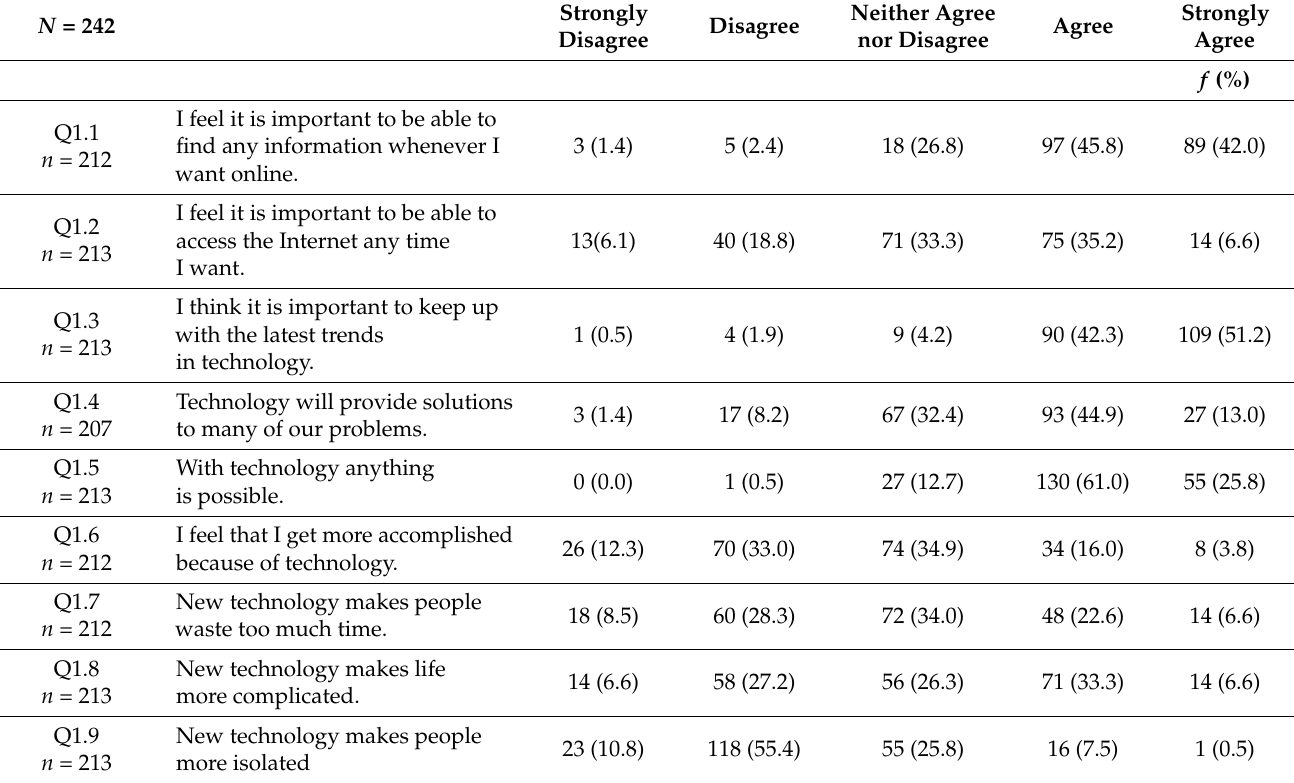
Table 2. Attitudes towards the technology of the surveyed